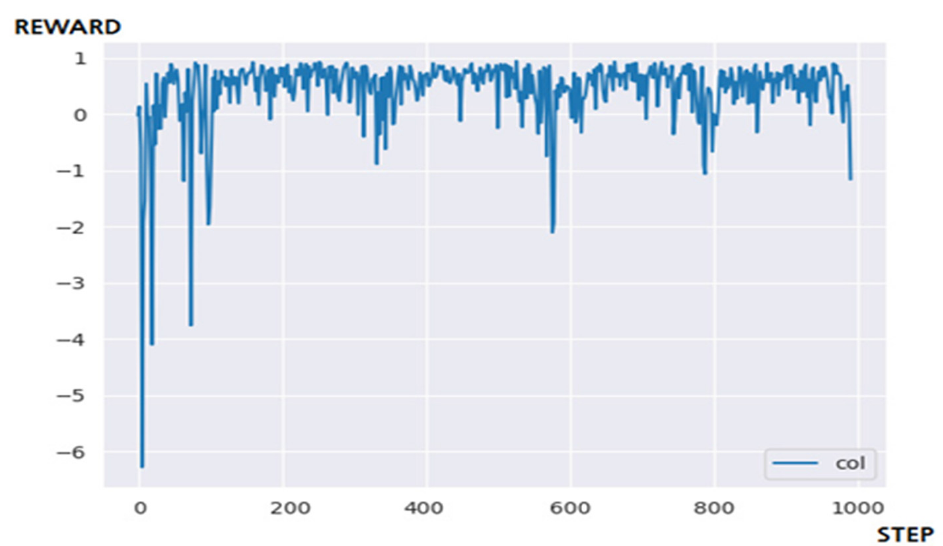
Figure 16. The result of the ping-pong game through DQN.